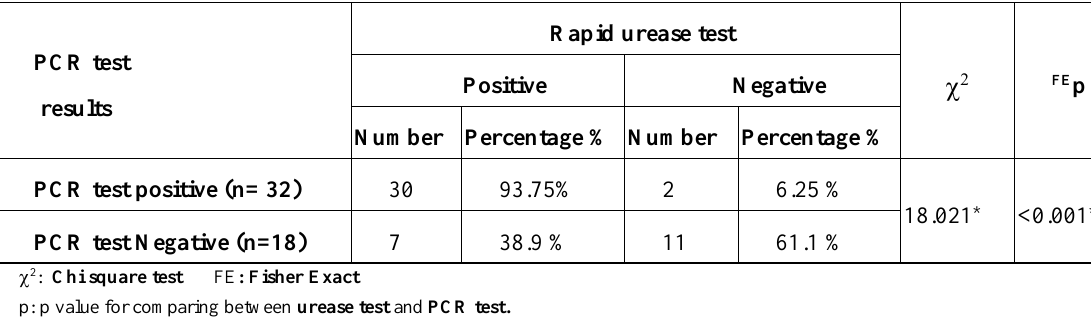
Table 1. Association between RUT results and PCR test results for H. pylori .